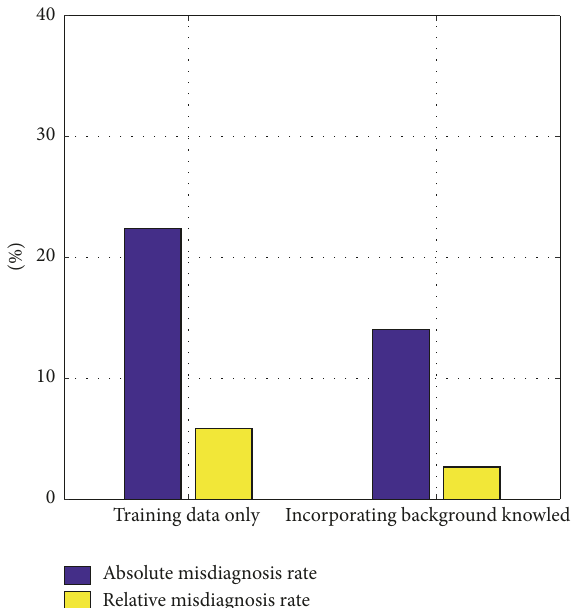
Figure 3: Average AMR and RMR from diagnosis with or without incorporating background